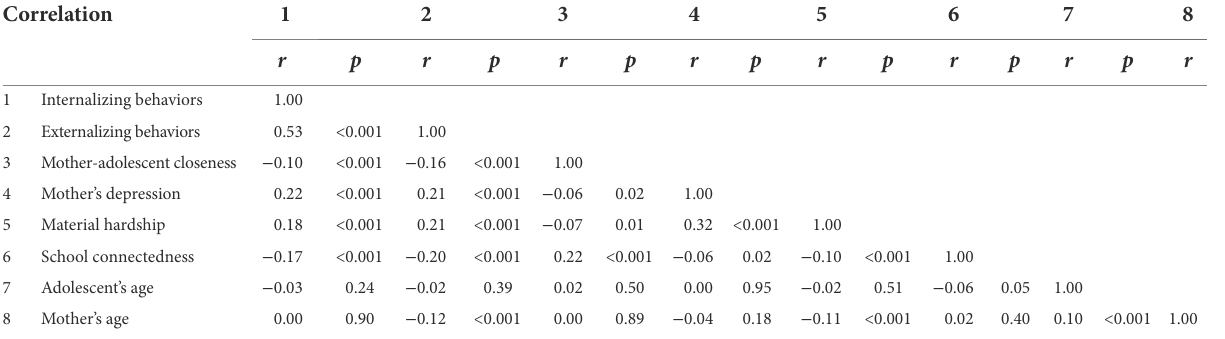
TABLE 2 Correlations of primary variables ( N =